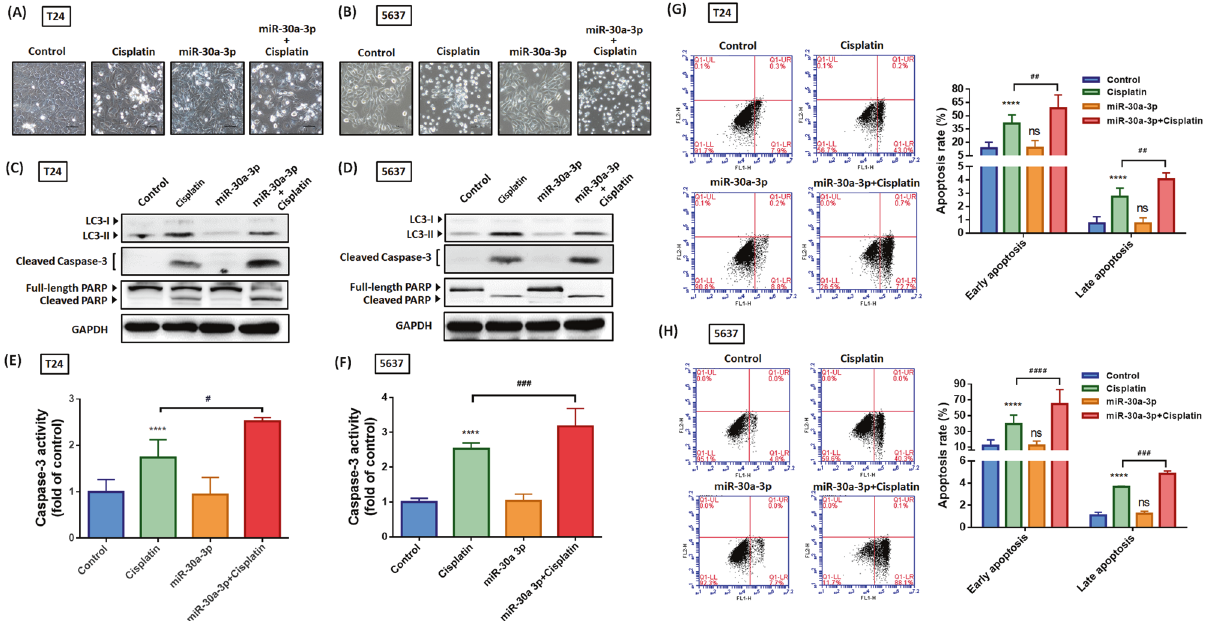
Fig. 7 Hsa-miR-30a-3p enhances chemosensitivity in BC cells. A , B Mono-administration of BC cells with cisplatin (20 μ M) or miR-30a-3p mimic (25 nM) or in combination for 24 h; cell morphology under a bright fi eld microscope was captured ( N = 3). C , D The BC cells were treated as described in ( A ). The protein levels of LC3-II, cleaved-caspase-3, and cleaved PARP were measured through western blot assay ( N = 4). E , F The BC cells were treated as described in ( A ); caspase-3 activity was analyzed using an EnzChek Caspase-3 assay kit ( N = 6). G , H Cell apoptosis analyses were performed using fl ow cytometry with FITC-conjugated Annexin V and PI staining ( N = 4). All data are expressed as means±SDs in triplicate samples. * P < 0.05, ** P <0.01, *** P < 0.001, and **** P <0.0001 relative to the control group; # P <0.05, ## P <0.01, ### P <0.001, and #### P <0.0001 relative to the cisplatin